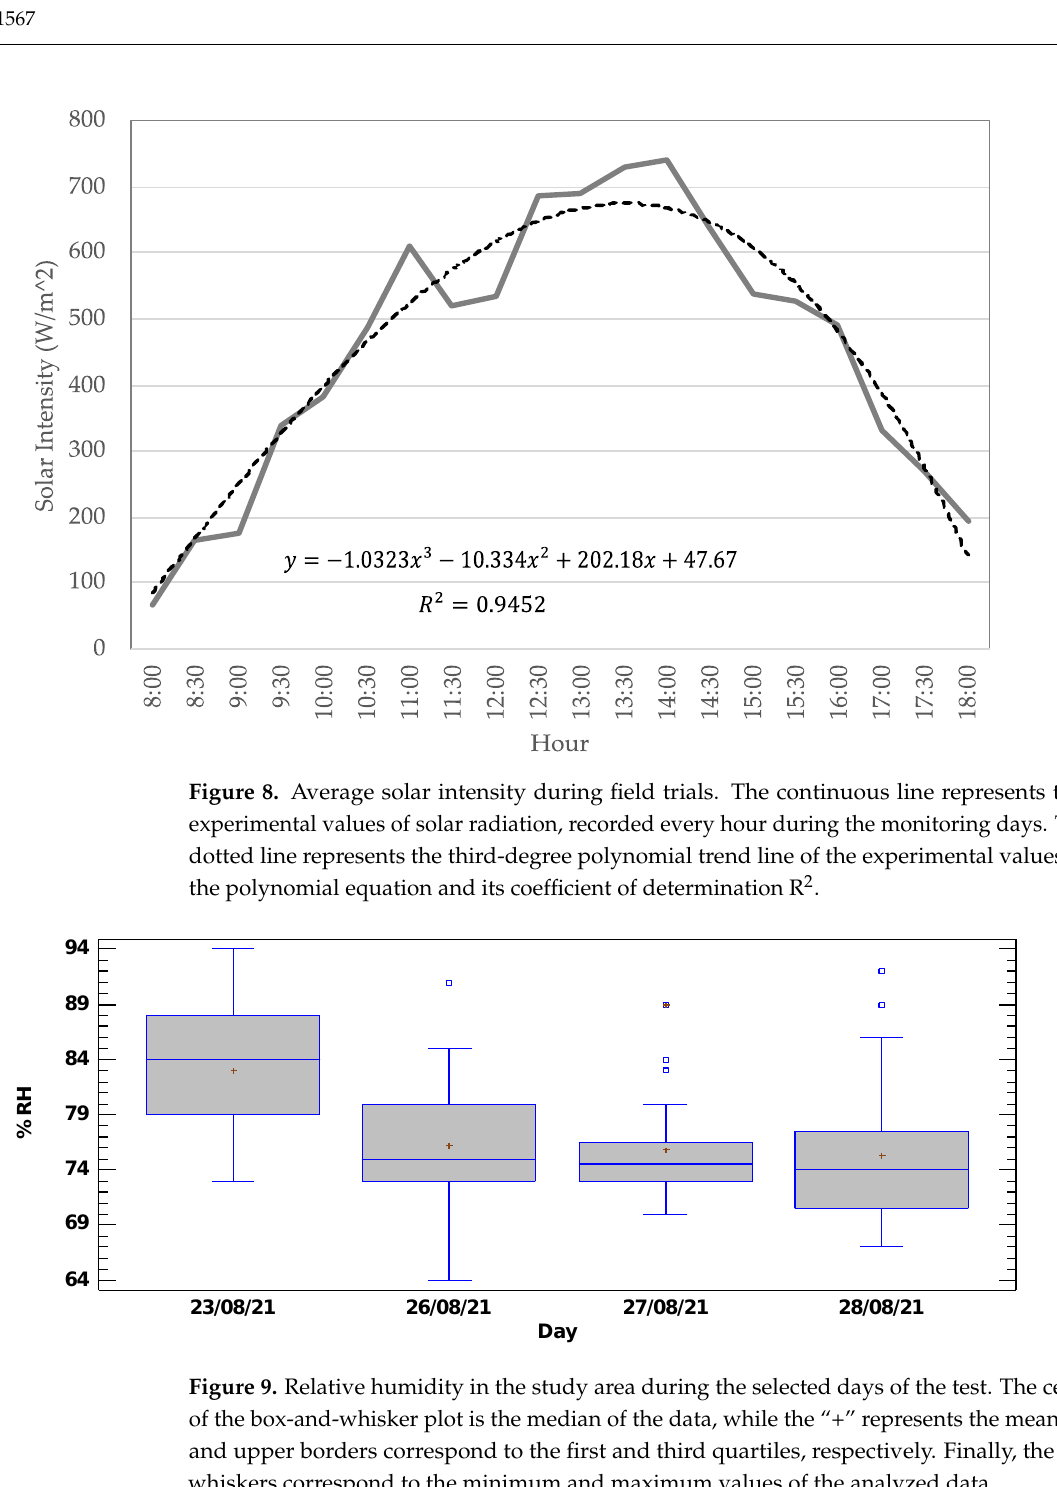
Figure 9. Relative humidity in the study area during the selected days of the test. The central value of the box-and-whisker plot is the median of the data, while the “+” represents the mean. The lower and upper borders correspond to the first and third quartiles, respectively. Finally, the ends of the whiskers correspond to the minimum and maximum values of the analyzed data.